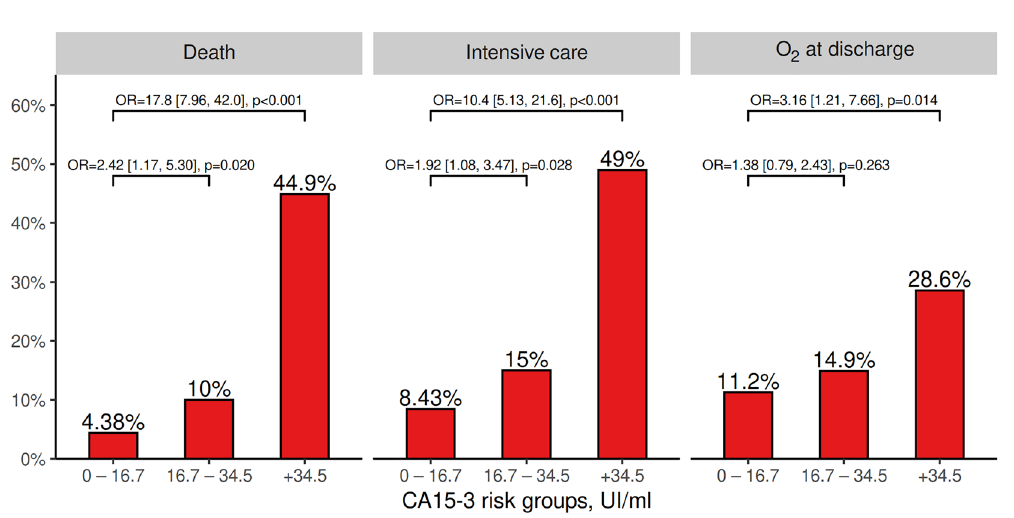
Figure 2. The rate of adverse events for each level of CA